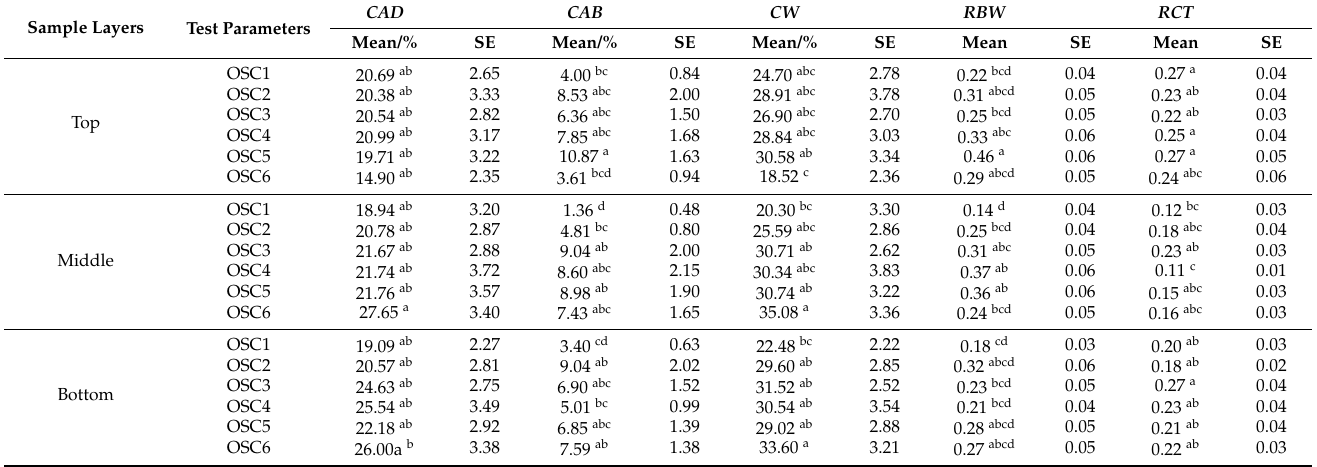
Table 4. Results of spray tests on cherry: CAD , CAB , CW , RBW, and RCT of OSC1-OSC6. Sample